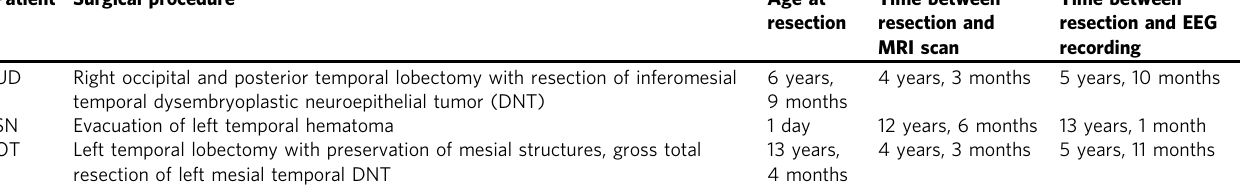
Table 2 Surgery history of patients 38 . Patient Surgical procedure